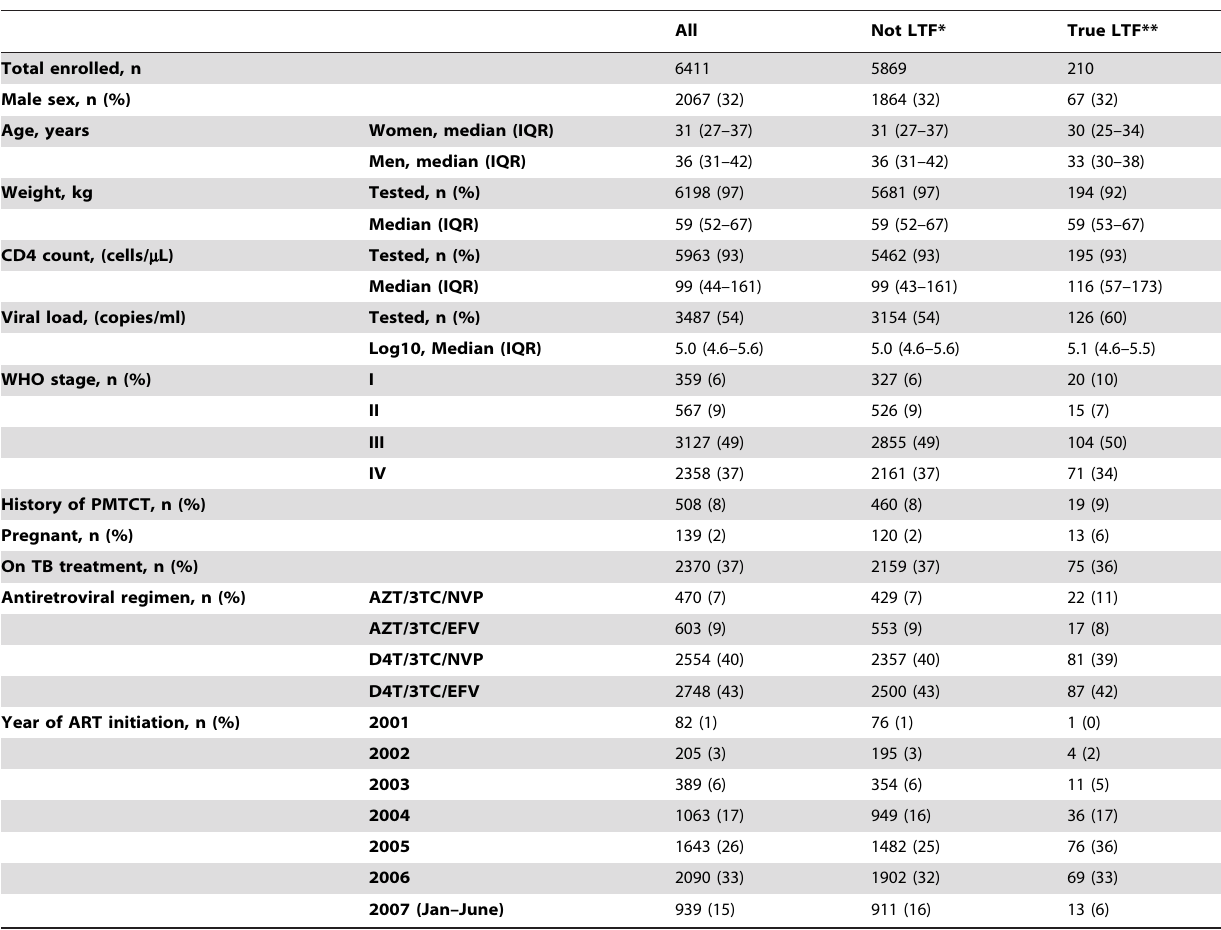
Table 1. Patient characteristics at initiation of